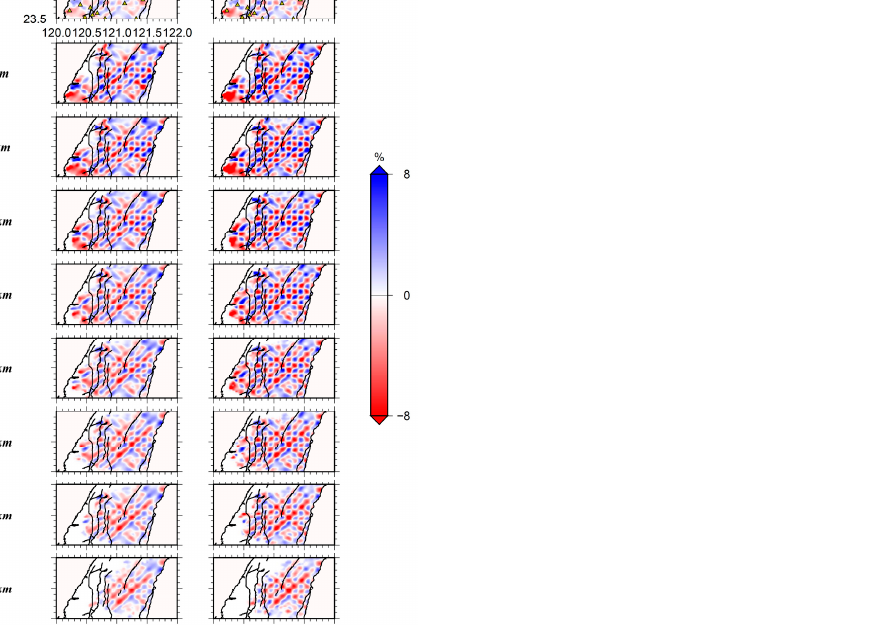
Figure 3. Perturbations of ±8% of Vp and Vs were added to generate a new 3D velocity model in the form of a checkerboard (grid distance: 10 × 10 km 2 ). Yellow triangles represent the stations. ( a ) Period II checkerboard of Vp. ( b ) Period II checkerboard of Vs.